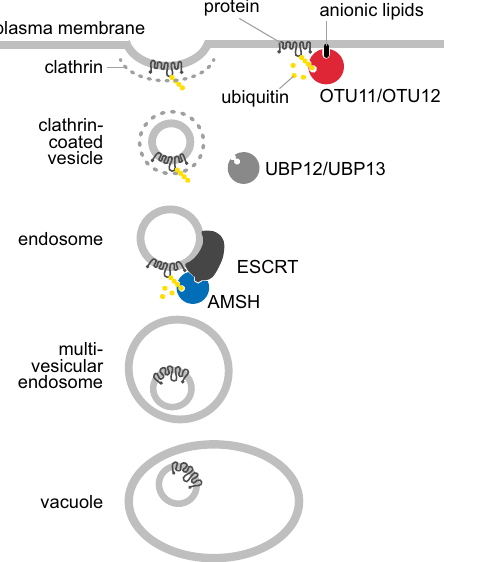
Fig.9|ModelforOTU11andOTU12function. InadditiontoDUBssuchasAMSHs, UBP12, and UBP13, OTU11 and OTU12 could fi ne-tune the endocytic degradation pathway. OTU11 and OTU12 are found at the PM. When bound to the anionic lipid- containingPM,theDUBactivityofOTU11andOTU12canbestimulated,andOTU11 and OTU12 can deubiquitylate ubiquitin-modi fi ed proteins at the PM. Deubiquity- lation of PM proteins could affect their af fi nity to ubiquitin-binding domains of ESCRT and ESCRT-accessory proteins. Thus, for the UB-dependent and ESCRT- mediatedendosomaldegradation,thebalanceoftheactivityofubiquitylating-and deubiquitylatingenzymescandetermineproteinstability.OTU11andOTU12canbe part of the molecular mechanisms modulating the endosomal transport and sub- sequent vacuolar degradation of PM